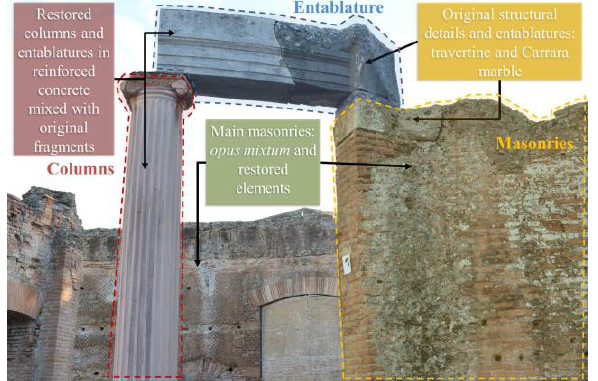
Figure 7. Inside architectural elements coexist different materials (restorations and original